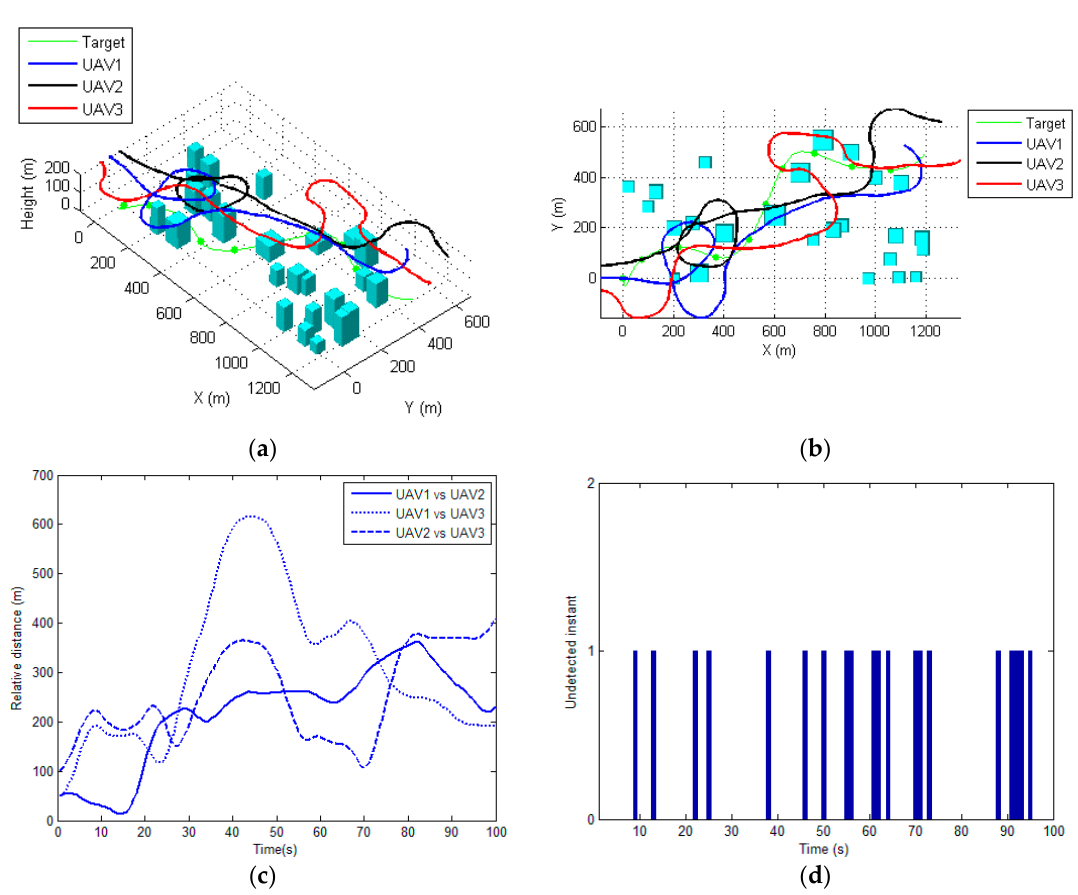
Figure 11. The results obtained by using LGVF based approach for scenario 2. ( a ) 3D view of the planned path for each UAV; ( b ) Top view of the resulting paths; ( c ) The relative distance between each UAV during tracking; ( d ) The undetected time-instant. Table 2. Statistics results of the tracking performances for scenario 1.